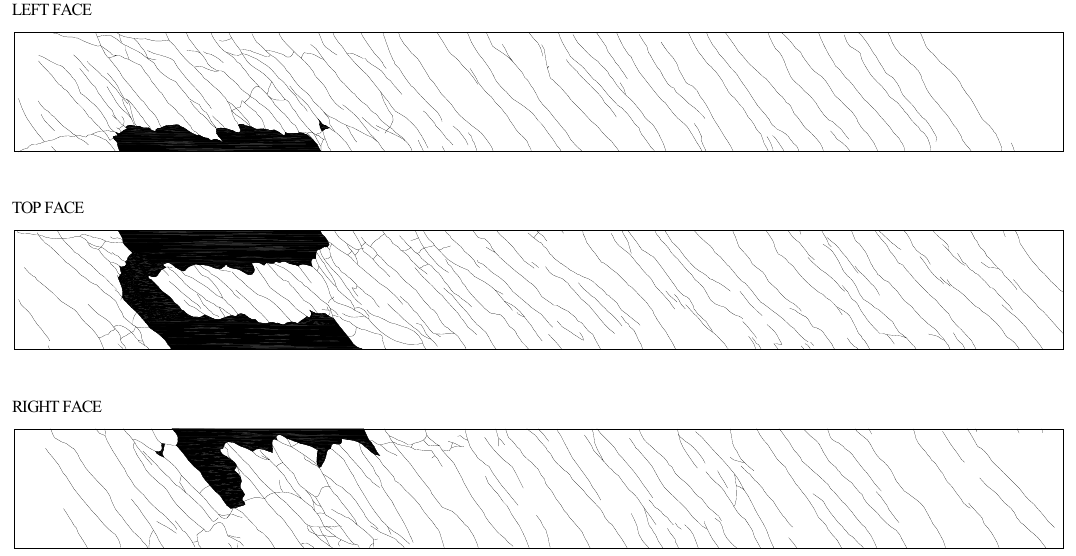
Figure 12. Cracking pattern: Beam D-0.